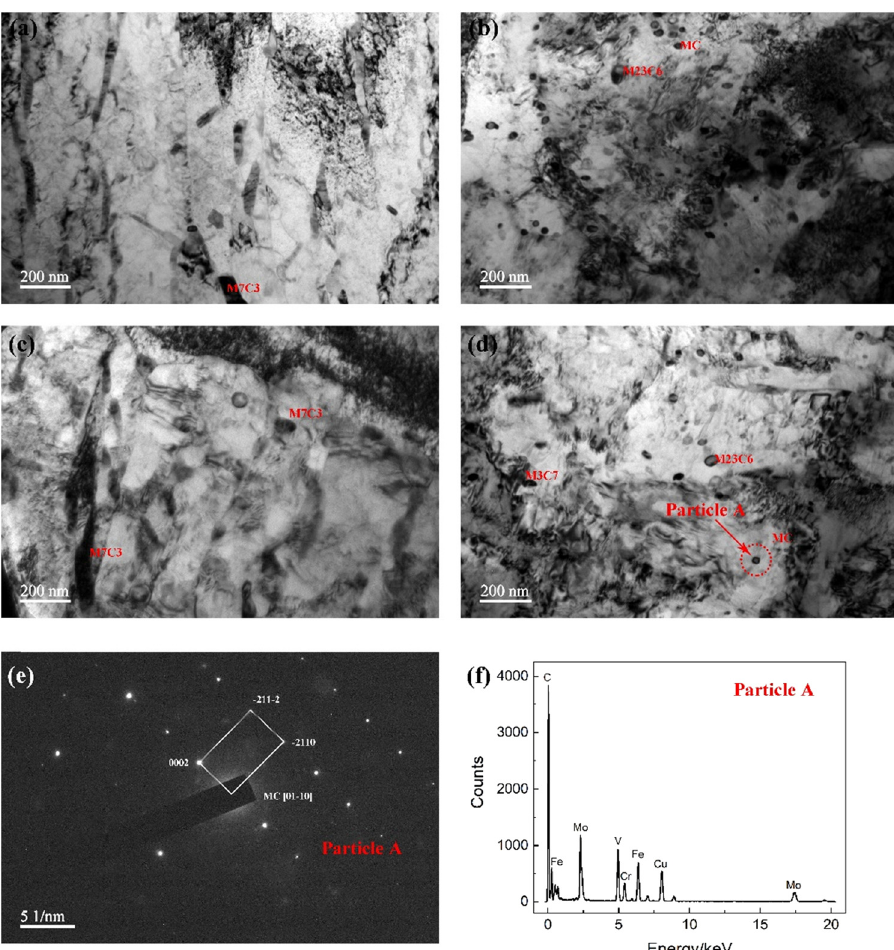
Figure 8: The tempered microstructure of the two steels by TEM at 600°C for di ff erent tempering times: ( a ) 2 h - 5CrNiMoV, ( b ) 2 h - 5CrNiMoVNb, ( c ) 24 h - 5CrNiMoV, ( d ) 24 h - 5CrNiMoVNb, ( e ) di ff raction of particle A, and ( f ) energy spectra of particle